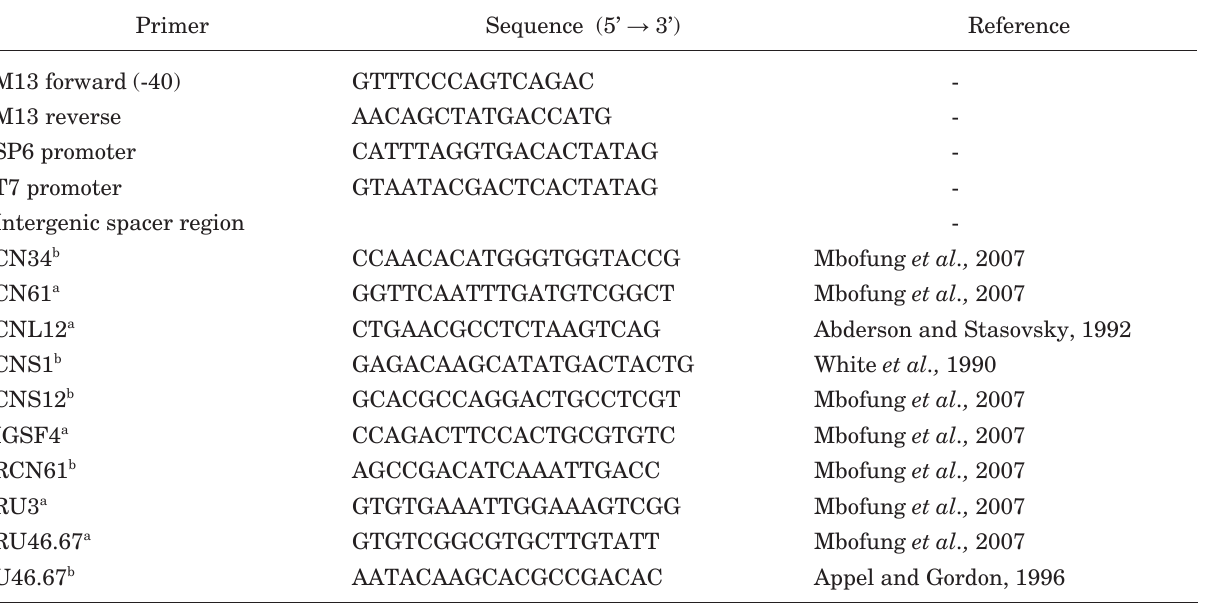
Table 2. Primers used in this